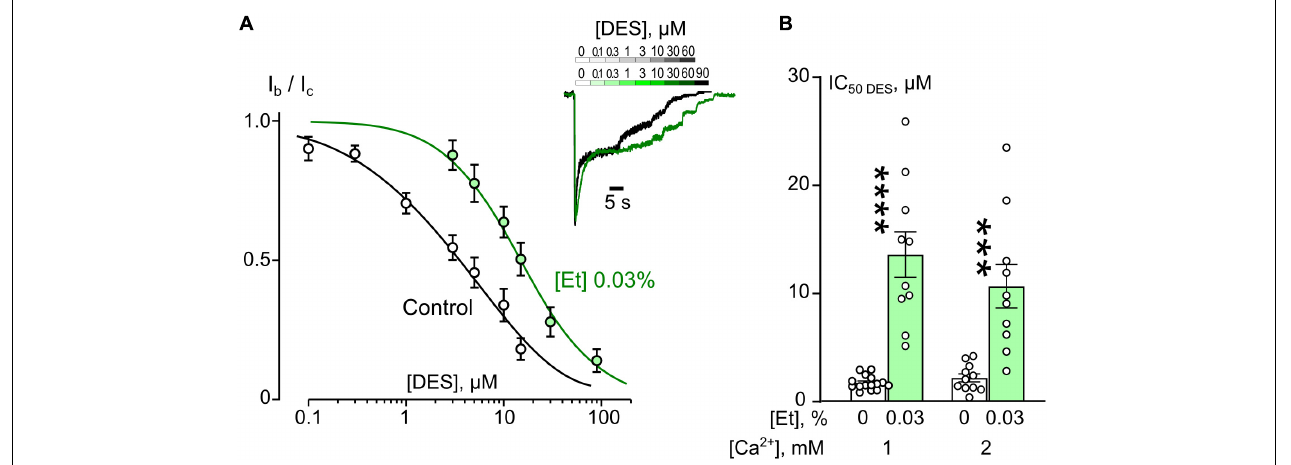
FIGURE 2 | Ethanol effects on desipramine (DES) inhibition of NMDAR currents. (A) Concentration-inhibition curves for DES inhibition of currents activated by 100 µ M NMDA + 30 µ M Gly obtained in 2 mM [Ca 2 + ] in the control bathing solution or in ∼ 6 mM ethanol ([Et] 0.03%). Symbols show mean values ± SEM of the relative amplitudes of currents (I b /I c ) in the presence (I b ) and absence (I c ) of different DES concentrations ([DES]). In insert sample traces of NMDAR currents normalized to the steady-state amplitude without DES, recorded at –70 mV in the presence of increasing DES concentrations in control (upper row) and in ethanol (lower row) are shown. (B) Dependence of IC 50 for inhibition of NMDAR currents by DES on extracellular [Ca 2 + ] and ethanol obtained from experiments illustrated in (A) . Data from each experiment (symbols) and mean values ± SEM are shown. Mean IC 50 values are summarized in Table 1 . Two-way ANOVA ([Ca 2 + ] × [Et]) revealed significant main effects of [Et] [ F ( 1 , 42 ) = 61.7, p = 0.0000000009] and no interaction between [Ca 2 + ] and [Et]. Data obtained in ethanol and without ethanol differ significantly in both 1 mM [Ca 2 + ] (**** p = 0.00000008) and 2 mM [Ca 2 + ] (*** p = 0.00011), two-way ANOVA with post hoc Tukey’s